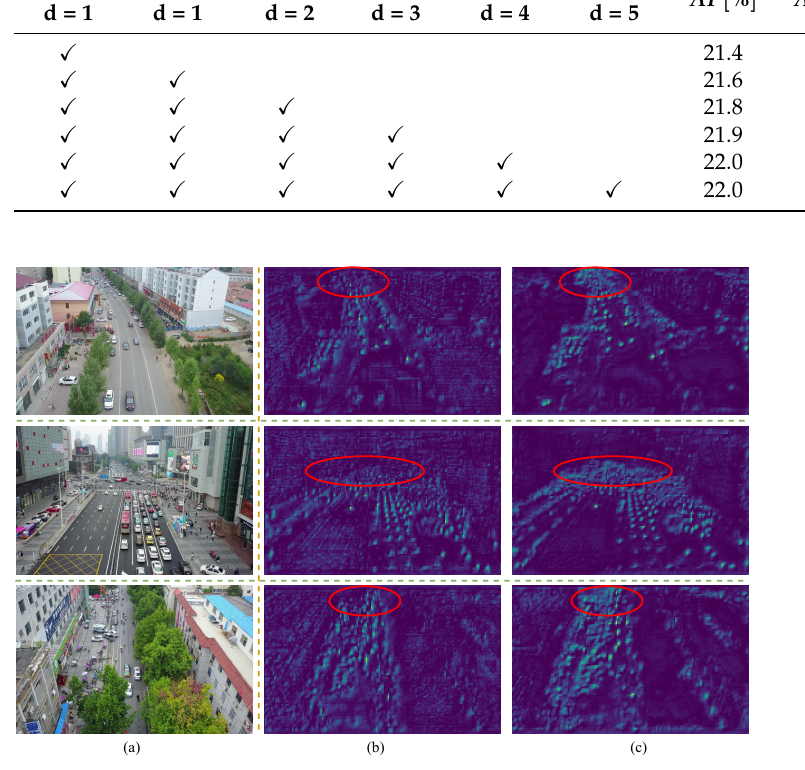
Figure 9. Visualization of the feature maps obtained with GLCC. ( a ) The input image. ( b ) Features obtained without GLCC. ( c ) Features obtained with